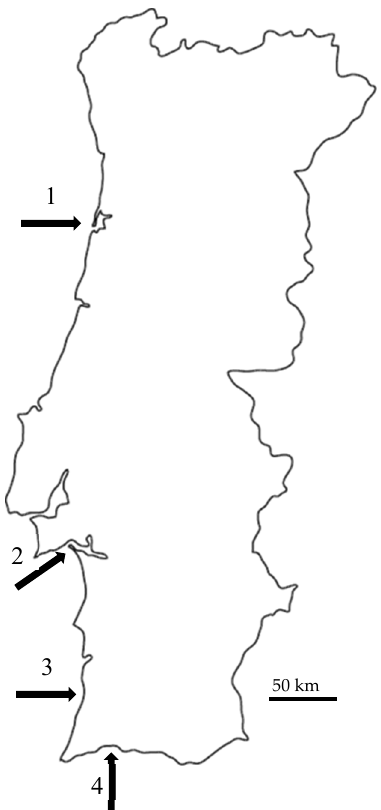
Figure 1. The map shows the areas were oysters were collected in mainland Portugal: Aveiro lagoon (1), Sado estuary (2), Mira estuary (3) and Alvor lagoon (4). Oysters (9–11 cm, aged 24 months old) were sampled from four different sites of the Portuguese coast. Crassostrea gigas is an exotic species that was introduced in Portugal, and so, its presence is restricted to some production areas (1 and 4). In areas 2 and 4, Crassostrea angulata were collected from wild beds.